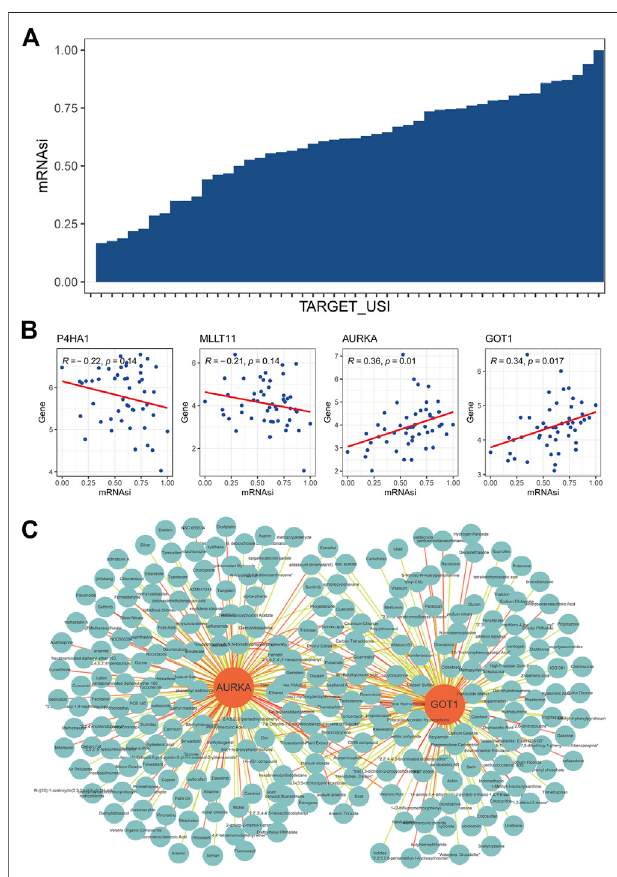
FIGURE 6 | Target drug prediction based on the tumor stem cell index. (A) Tumor stem cell index (mRNAsi) of MRTK samples based on the OCLR algorithm. TARGET_USI: unique sample identity document (USI) for 50 MRTK samples from the TARGET database; (B) correlation analysis between mRNAsi and P4HA1, MLLT11, AURKA, and GOT1; (C) Interaction between targetdrugs andprognosticfactors thatarepositivelycorrelatedwithmRNAsi